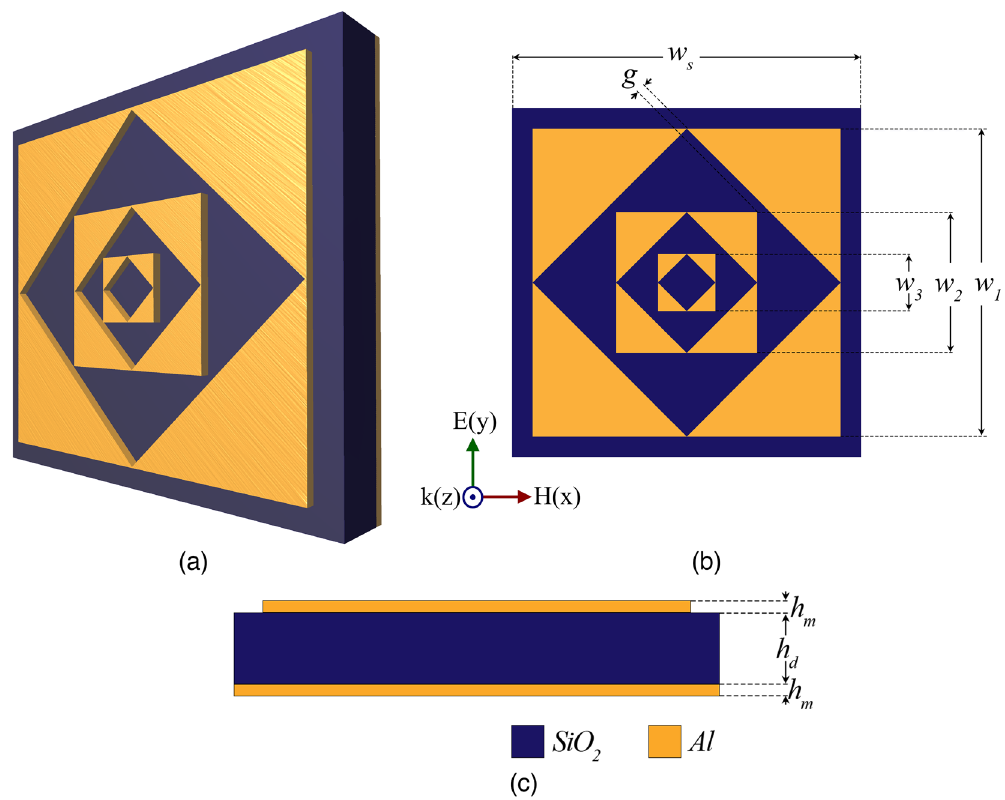
Figure 1. The configuration of fractal metamaterial absorber (FMMA) ( a ) 3D-view, ( b ) Top view with dimensions ( c ) Side view. The figure was created using Adobe Photoshop CC 2022 (Version 23.4.1, https:// www. adobe. com/ produ cts/ photo